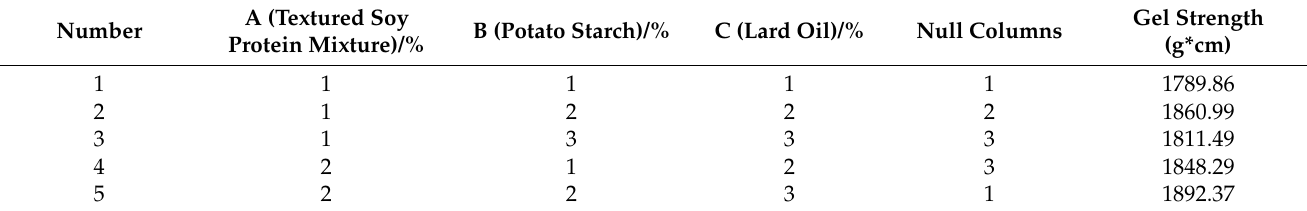
Table 3. Orthogonal experimental design